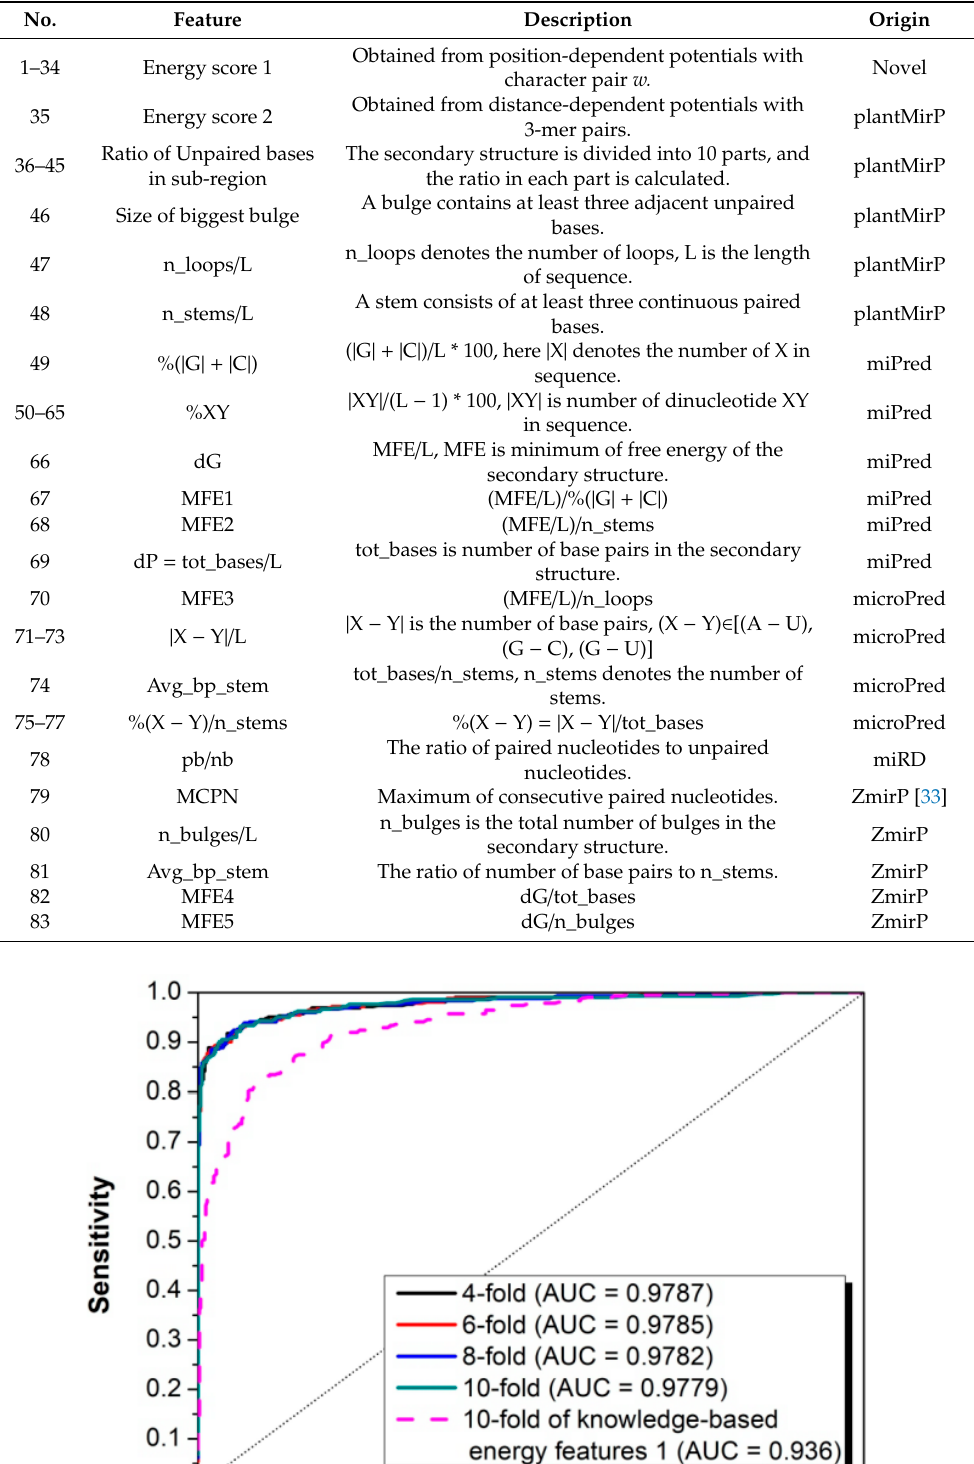
Table 1. Full features used in plantMirP-rice (riceMirP)